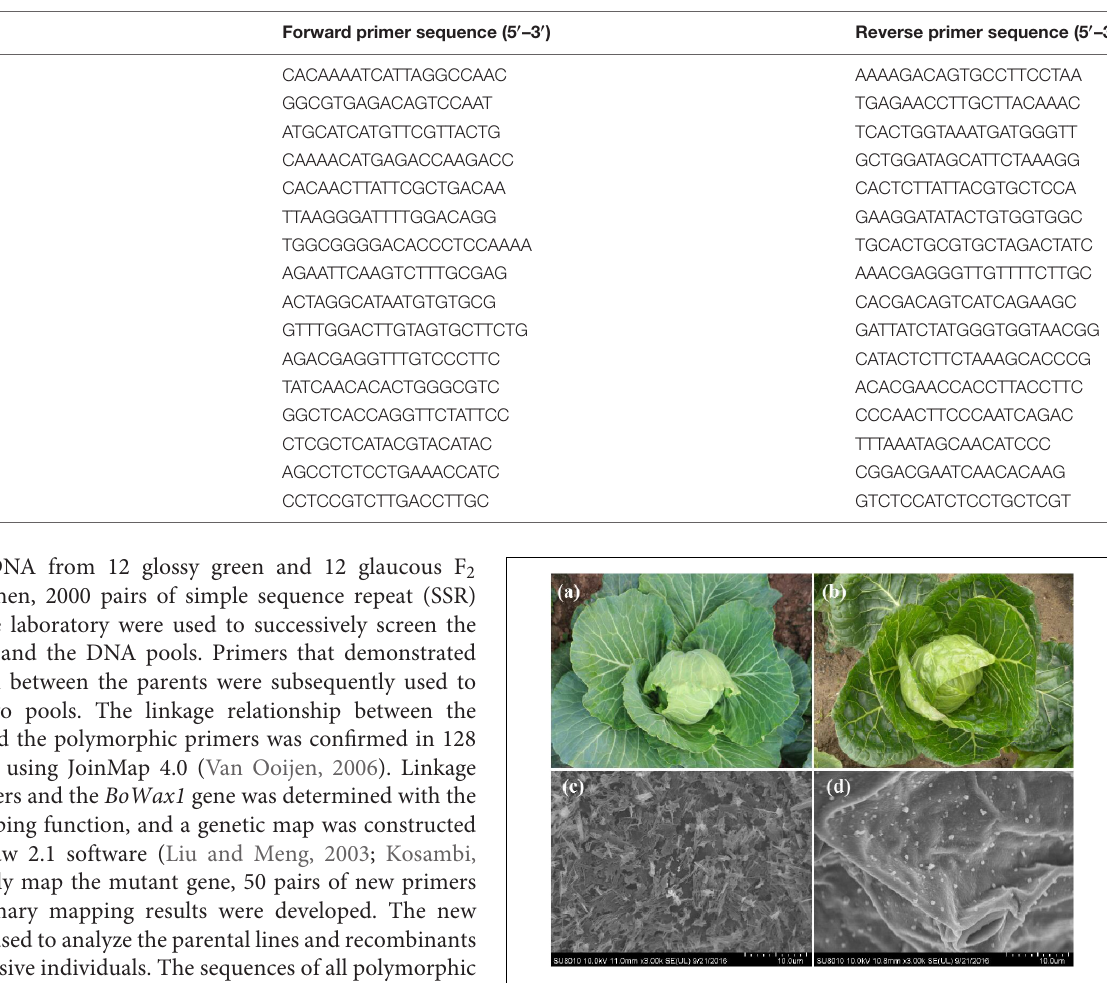
TABLE 1 | Sequences of primers used in this study.